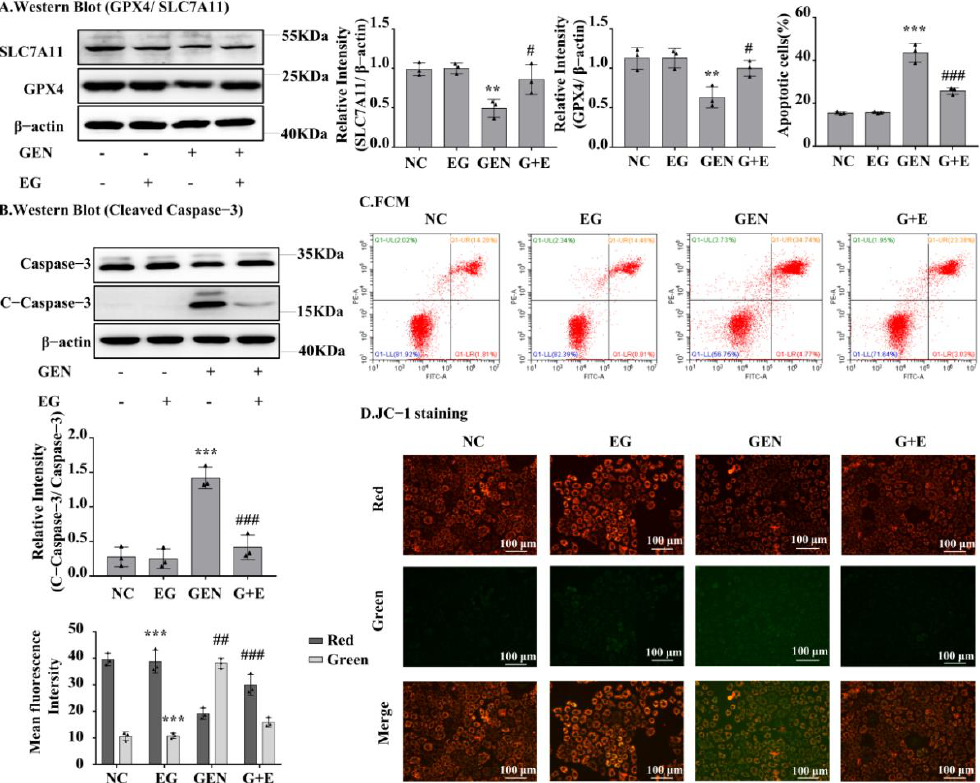
Figure 4. EG reduced GEN-induced apoptosis and ferroptosis of NRK-52E cells. ( A ) The Western blot analysed the levels of the GPX4 and SLC7A11 in NRK-52E cells. ( B ) The Western blot analysed the level of the cleaved-caspase-3 in NRK-52E cells. ( C ) Apoptosis of NRK-52E cells was analysed by flow cytometry. ( D ) JC-1 staining showed the changes of mitochondrial membrane potential in NRK-52E cells. Enhanced red fluorescence indicated formation of JC-1 aggregates, suggesting a relatively intact mitochondrial membrane. Enhanced green fluorescence indicated the production of JC-1 monomer, suggesting the destruction of mitochondrial membrane. Scale bars = 100 μm. In vitro data was expressed as mean ± SEM of three independent experiments. ** p < 0.01, *** p < 0.001 vs. control group; # p < 0.05, ## p < 0.01, ### p < 0.001 vs. GEN group.